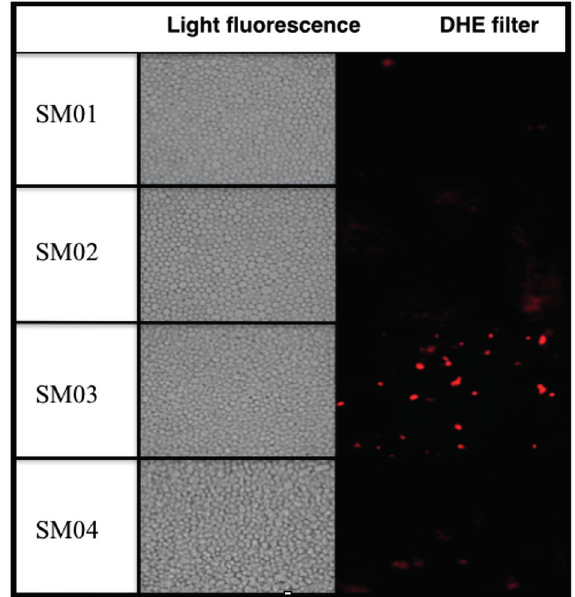
Figure 6. Visualization of oxidative stress via fluorescence microscopy of dihydroethidium (DHE)-stained strains.